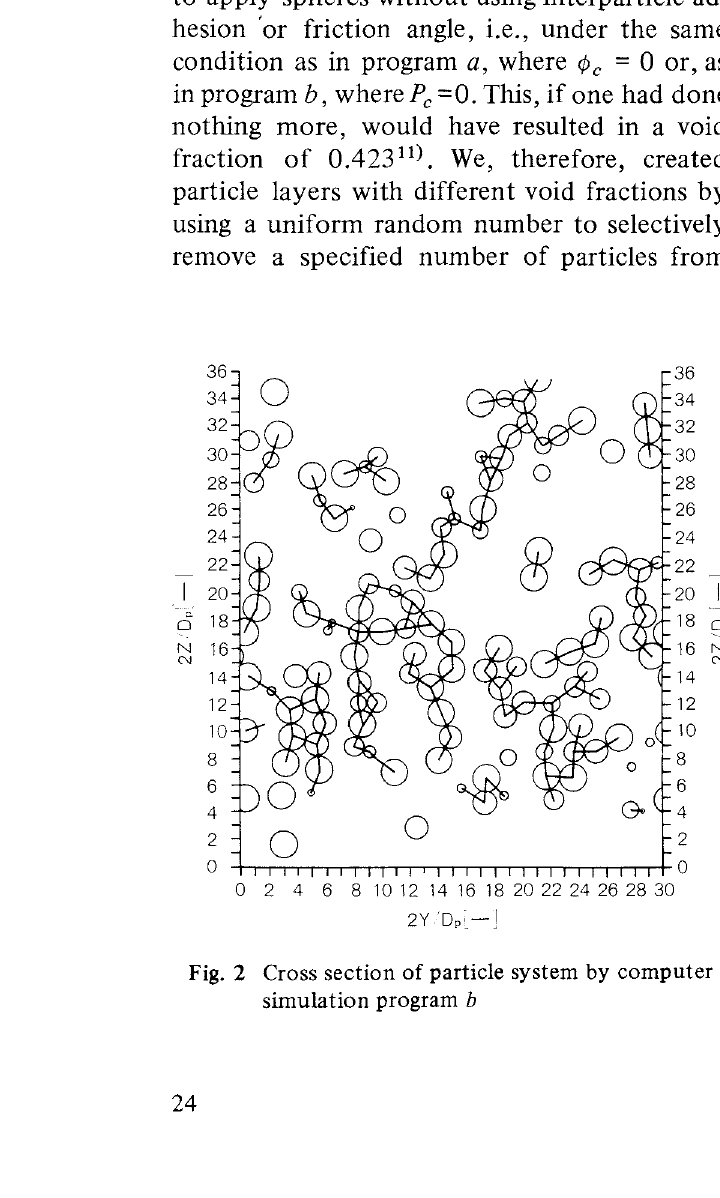
Fig. 2 Cross section of particle system by computer simulation program b